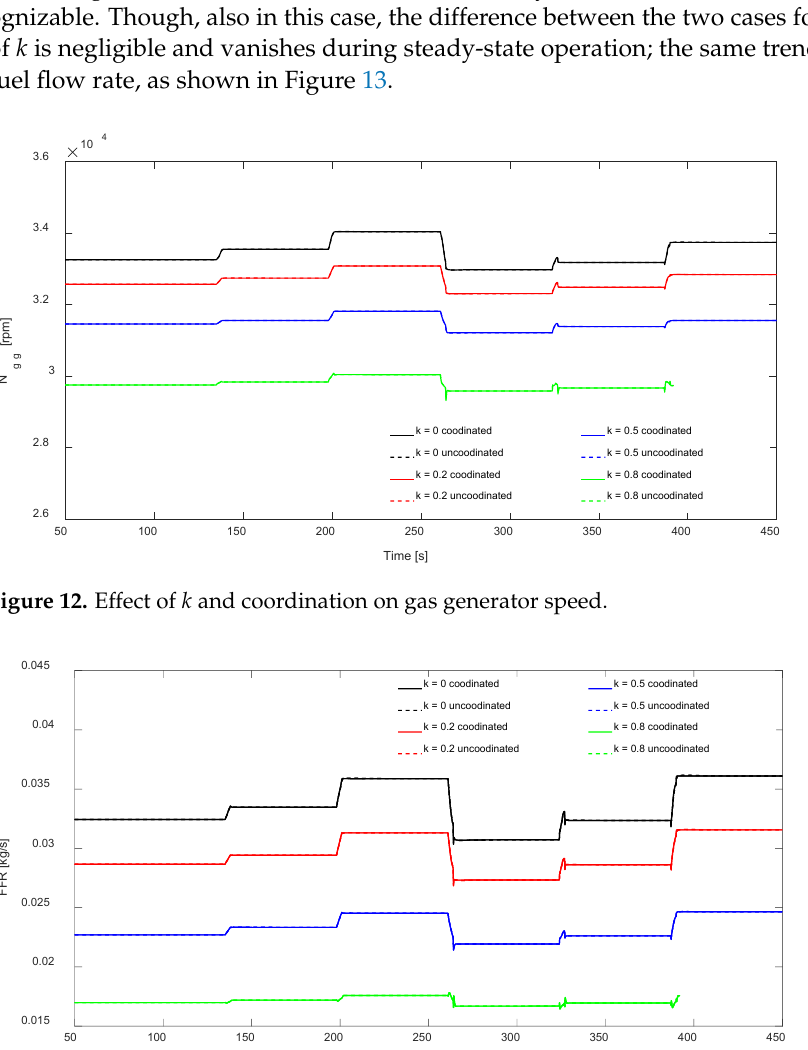
Figure 11. Effect of k and coordination on battery discharge.